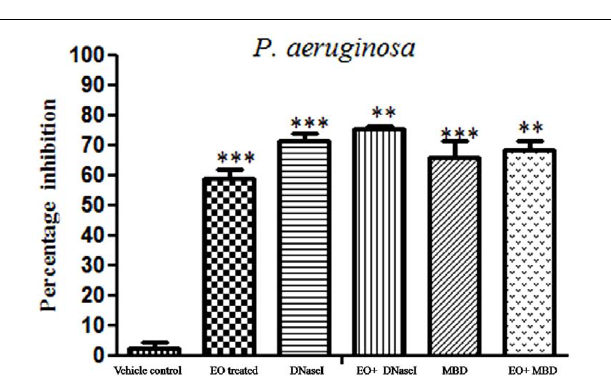
FIGURE 1 | Growth curve of P. aeruginosa treated with EO of C . tamala after 24 h incubation.